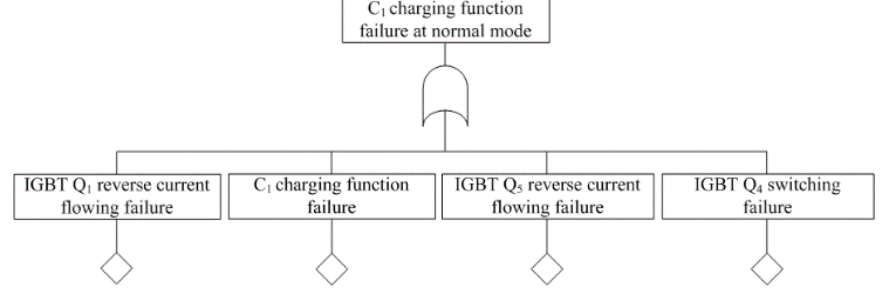
Figure 6. Sub fault tree for C 1 charging function failure at normal mode.